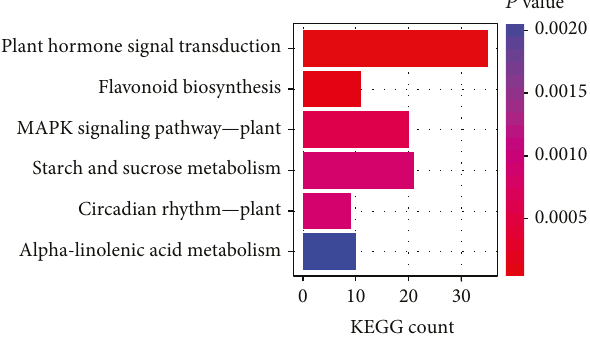
Figure 2: Functional enrichment analysis of di ff erentially expressed genes. Pathways with adjusted P value < 0.05 were shown (see Materials and Methods).